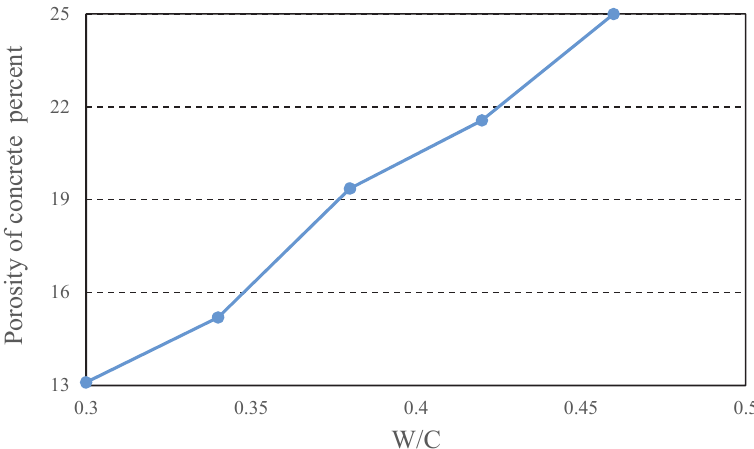
Figure 7: Variation of porosity in terms of different amounts of water-cement